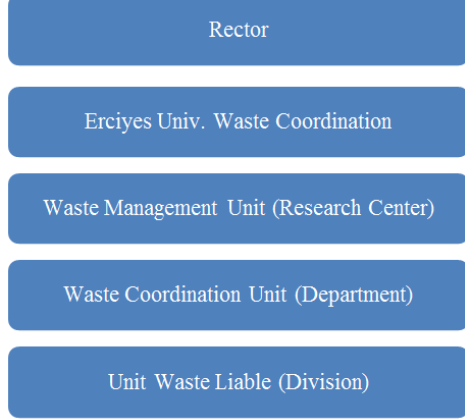
Figure 1. Erciyes University waste management hierarchy